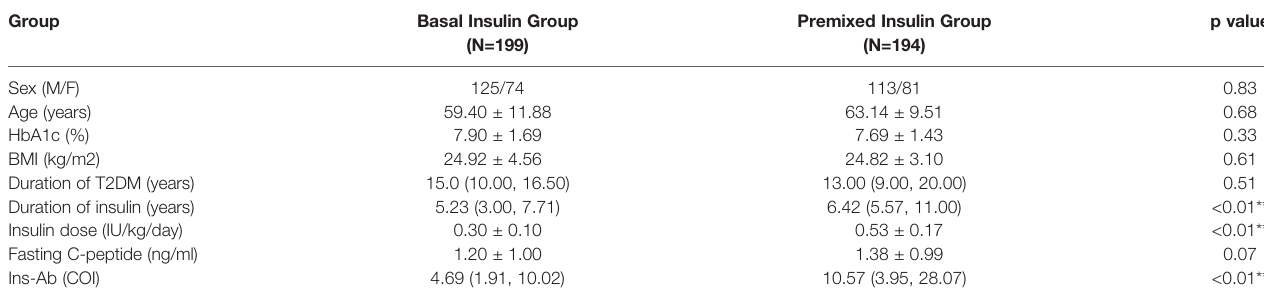
TABLE 1 | Baseline characteristics of